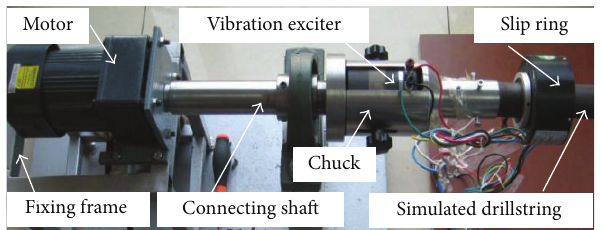
Figure 9: Physical picture of rotary vibration excitation